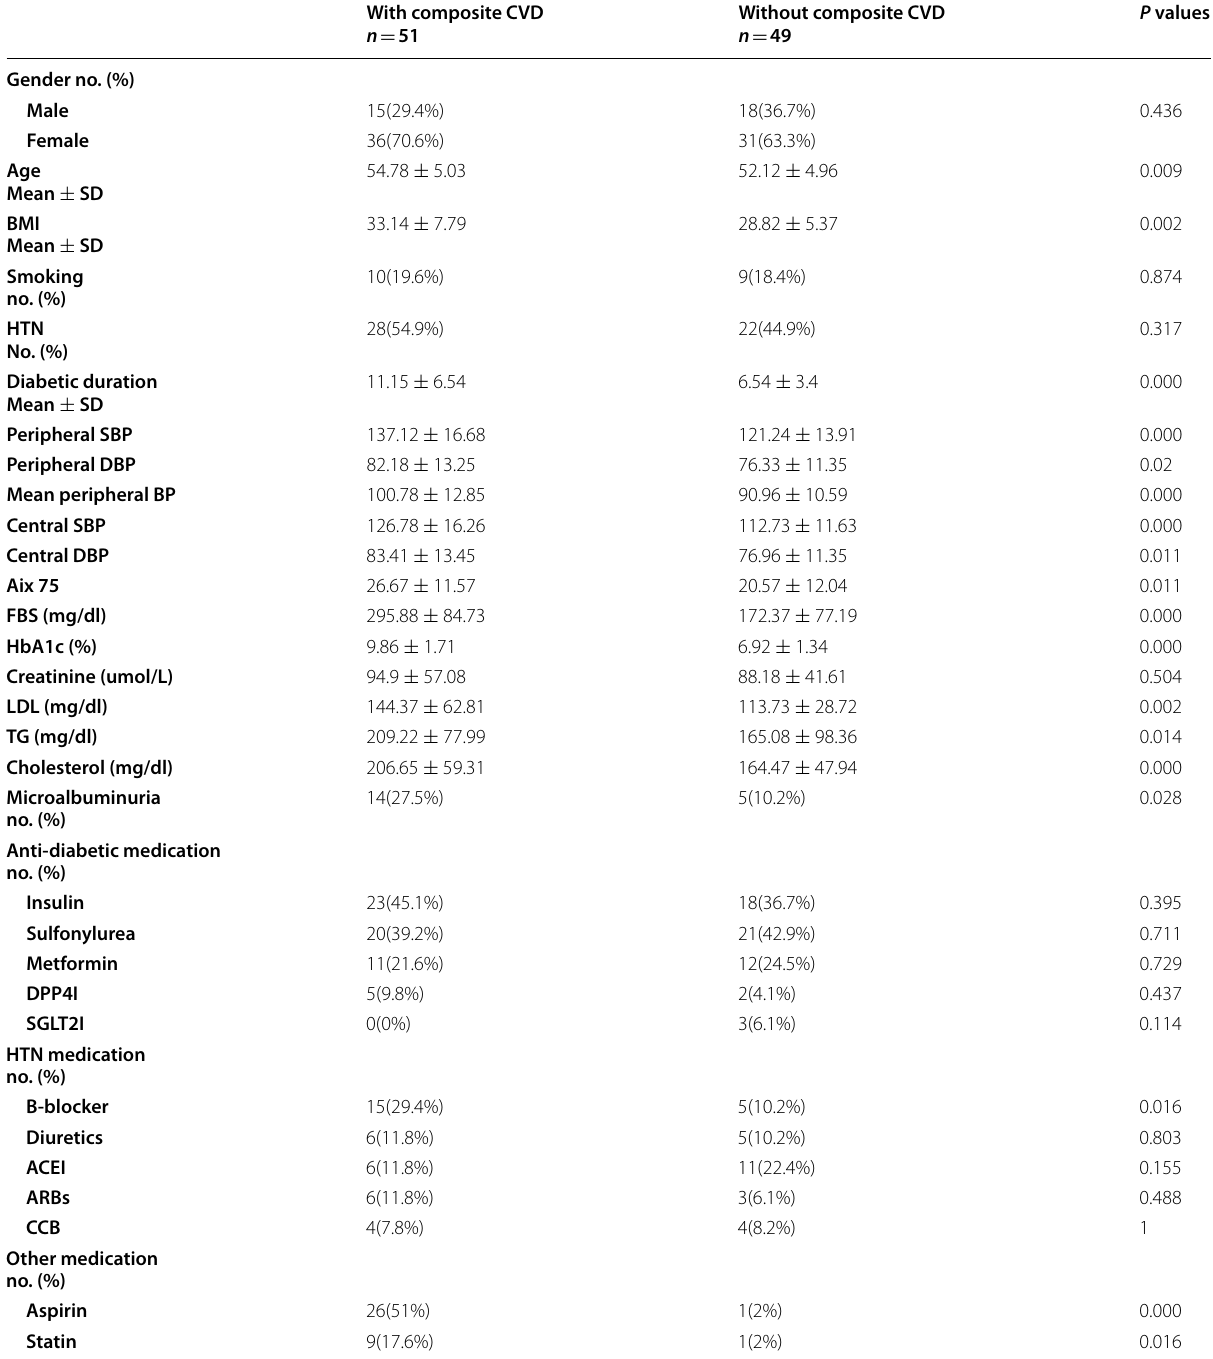
Table 1 Characteristics of diabetic with composite CVD and without composite CVD groups